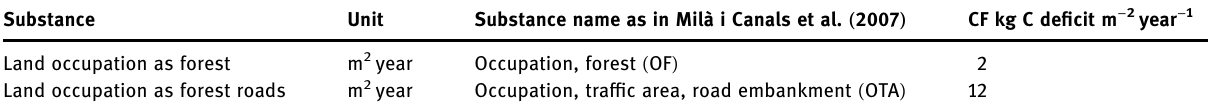
Table 2: CFs for occupation fl ows from Milà i Canals et al. [ 29 ]